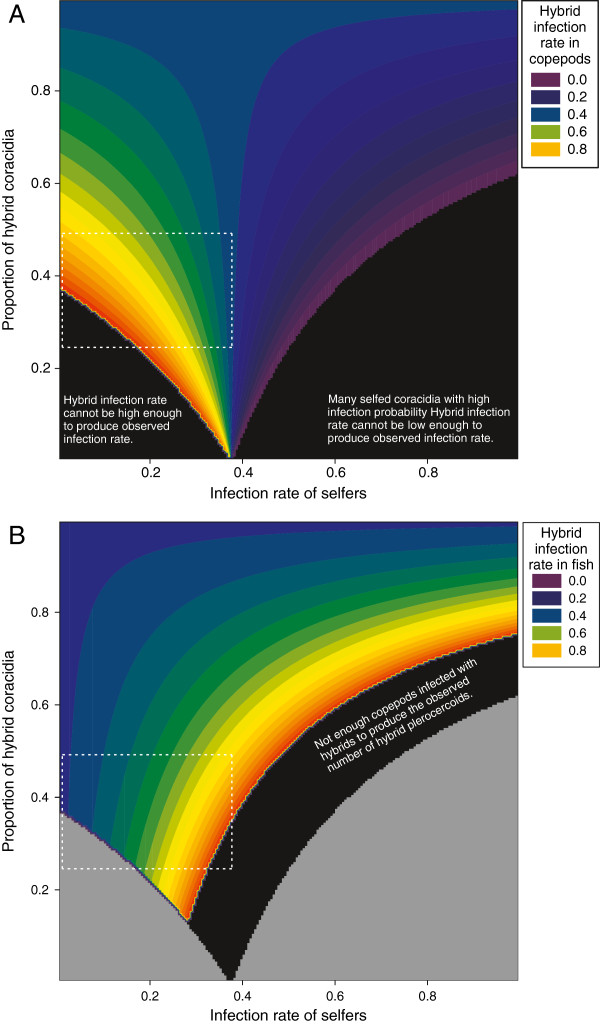
Contour plots of the infection rate of hybrids in copepods (A) and sticklebacks (B) that reproduce the observed data. Contours are plotted as a function of the infection rates of self-fertilized worms in copepods and the proportion of hybrid coracidia. See the main text for the equations used to calculate the hybrid infection rates. Black areas represent parameter space in which the observed results cannot be reproduced; intuitive explanations for this are given in each case. The gray areas in (B) are the black areas from (A). Dashed white lines delineate the parameter space that we consider most plausible. The boundaries of this area on the y-axis were based on observed hybridization rates, which ranged from 0.24 to 0.49. The width on the x-axis was based on the assumption that, due to inbreeding depression, the infection rate of selfers is probably lower than the overall mean (0.375).